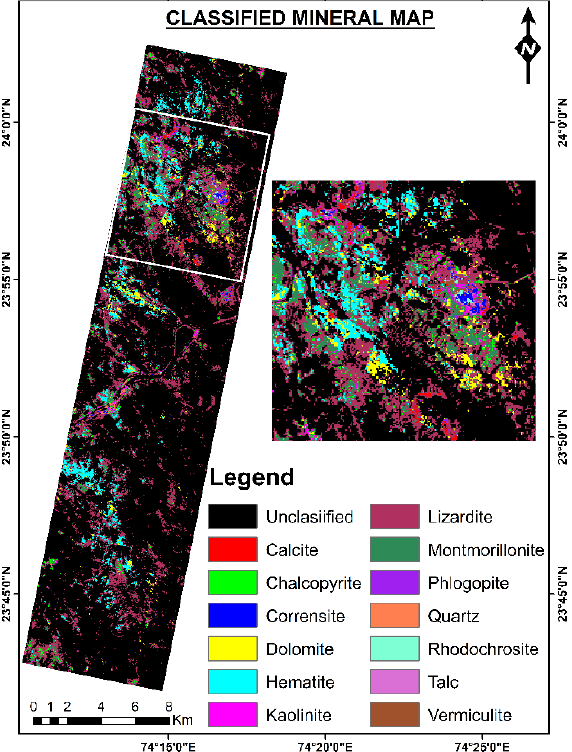
Figure 3. Mineral map, classified using spectral angle mapper (SAM)